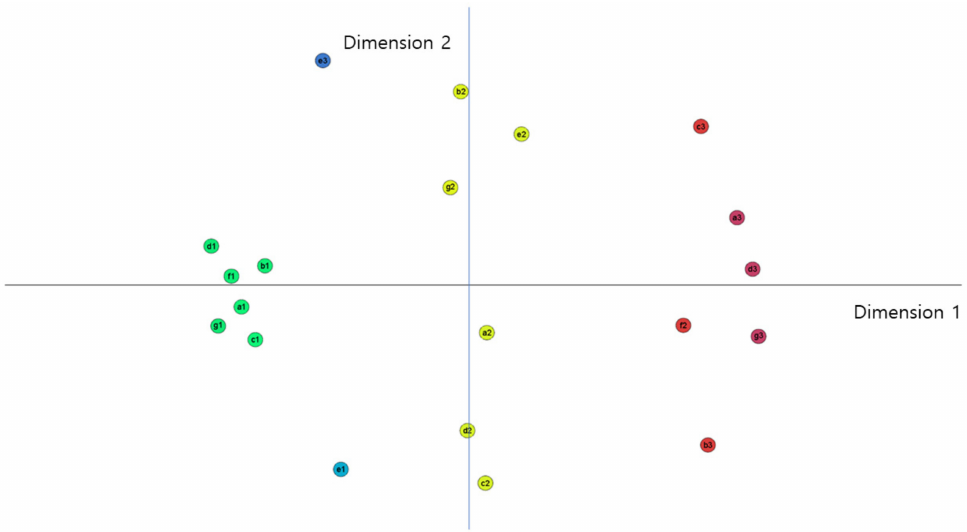
Figure 2. Results of MDS (expert evaluation mean). 1: Standardized circle stress: 0.067; explained